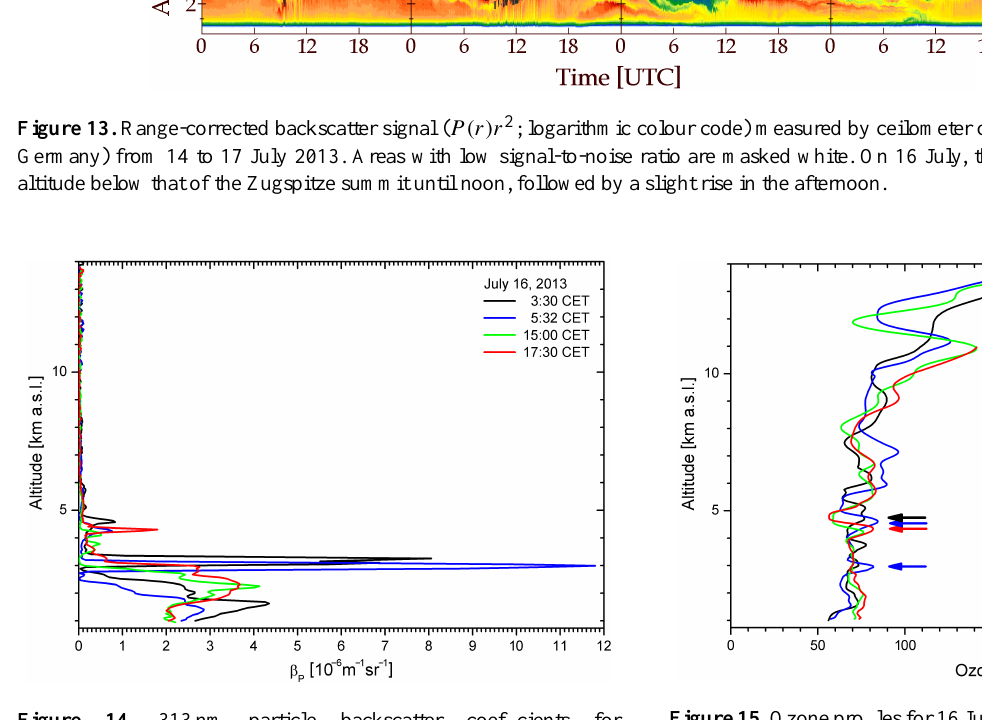
Figure 14. 313nm particle backscatter coefficients for 16 July 2013; the peak backscatter coefficient at 05:32CET, 1 . 2 × 10 − 5 , corresponds to a horizontal standard visual range of the order of 6.5km.